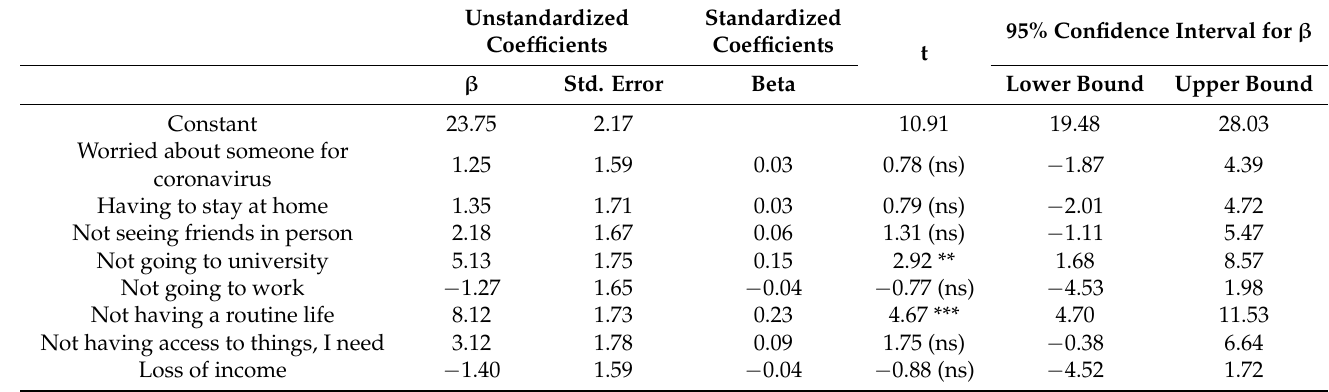
Table 5. Multiple regression analysis to examine the factors associated with the poor emotional well-being of students due to events/changes during the COVID-19 pandemic, including online studies ( n =